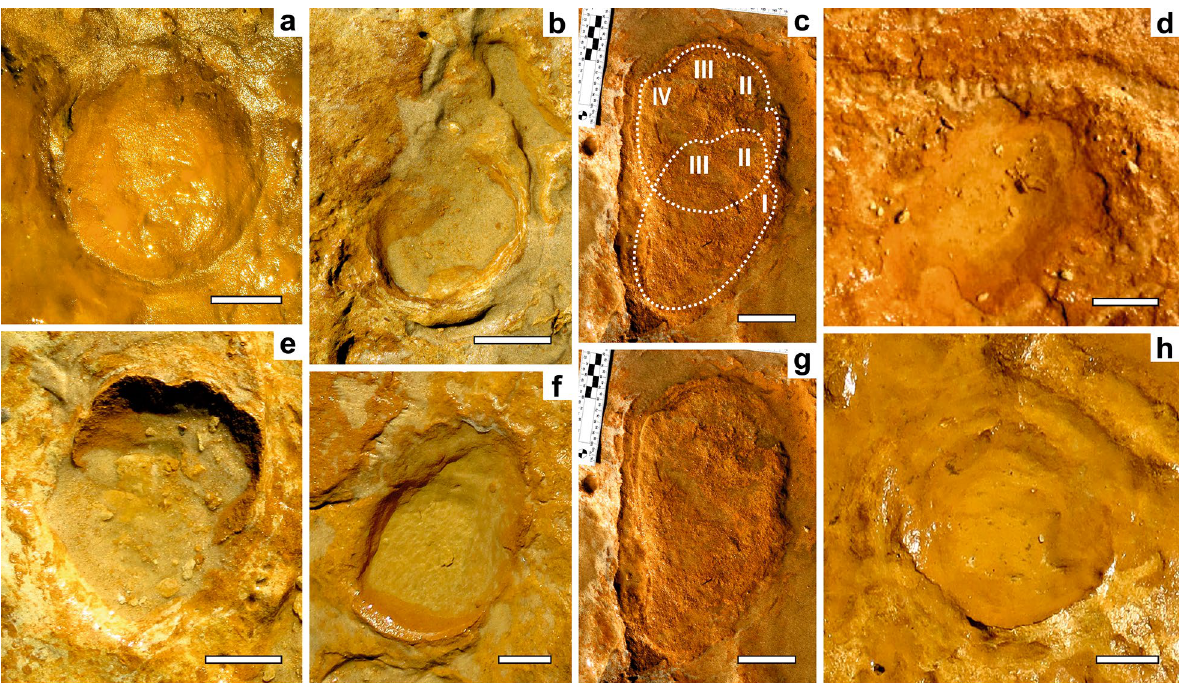
Figure 2. Proboscidean tracks ( Proboscipeda panfamilia ) attributed in the MTS to straight-tusked elephants. ( a – h ) Morphological features of small-sized tracks produced by calves and juveniles. Examples of manus impressions in ( a ) PAT/MTS/011a, ( b ) PAT/MTS/016 and ( f ) PAT/MTS/015x, and for further interpretation of ( a ) see Fig. 3; the latter two with drag marks made during the foot-off event. ( c ) and ( g ) PAT/MTS/002a,b: Manus-pes couple found isolated showing heteropody and different number of toe impressions (interpretation as left-side tracks by peak pressure deformation in the left side of the track according to 27 ); interpretation in ( c ). ( d ) PAT/MTS/014 and ( e ) PAT/MTS/007a: Calf-sized pes with three toe impressions. ( h ) PAT/MTS/011 h: Badly preserved manus of a calf. Scale bar = 5